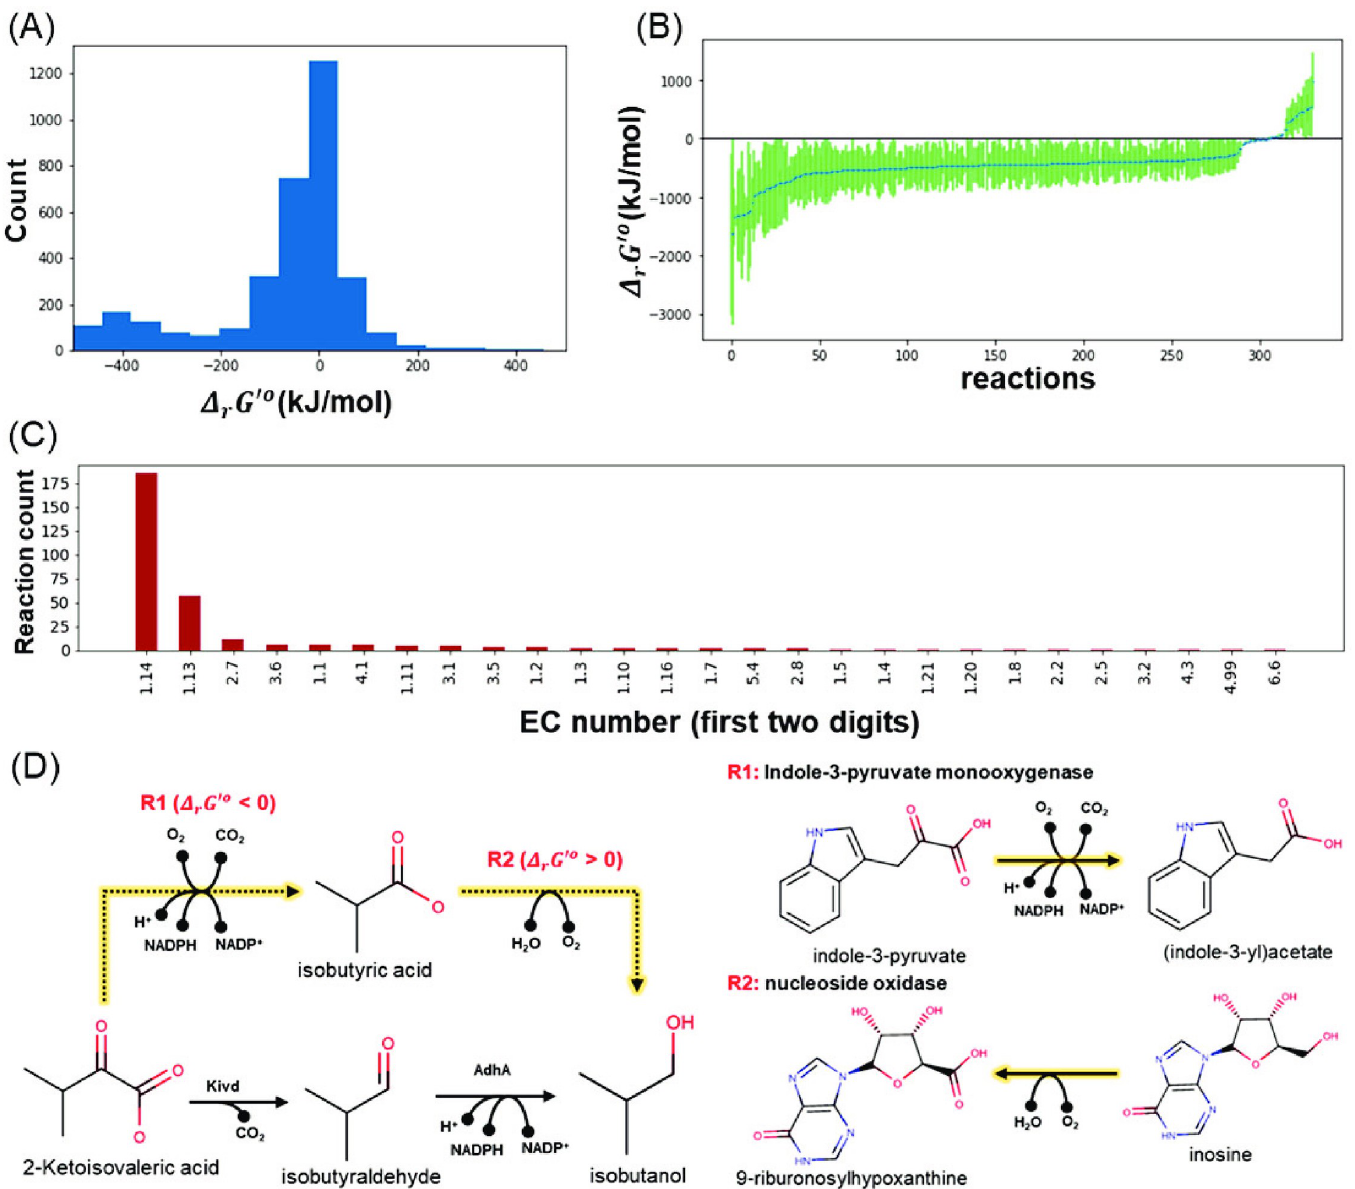
0 o for all the 3,603 reaction rules, (B) 331 reaction rules found to r G